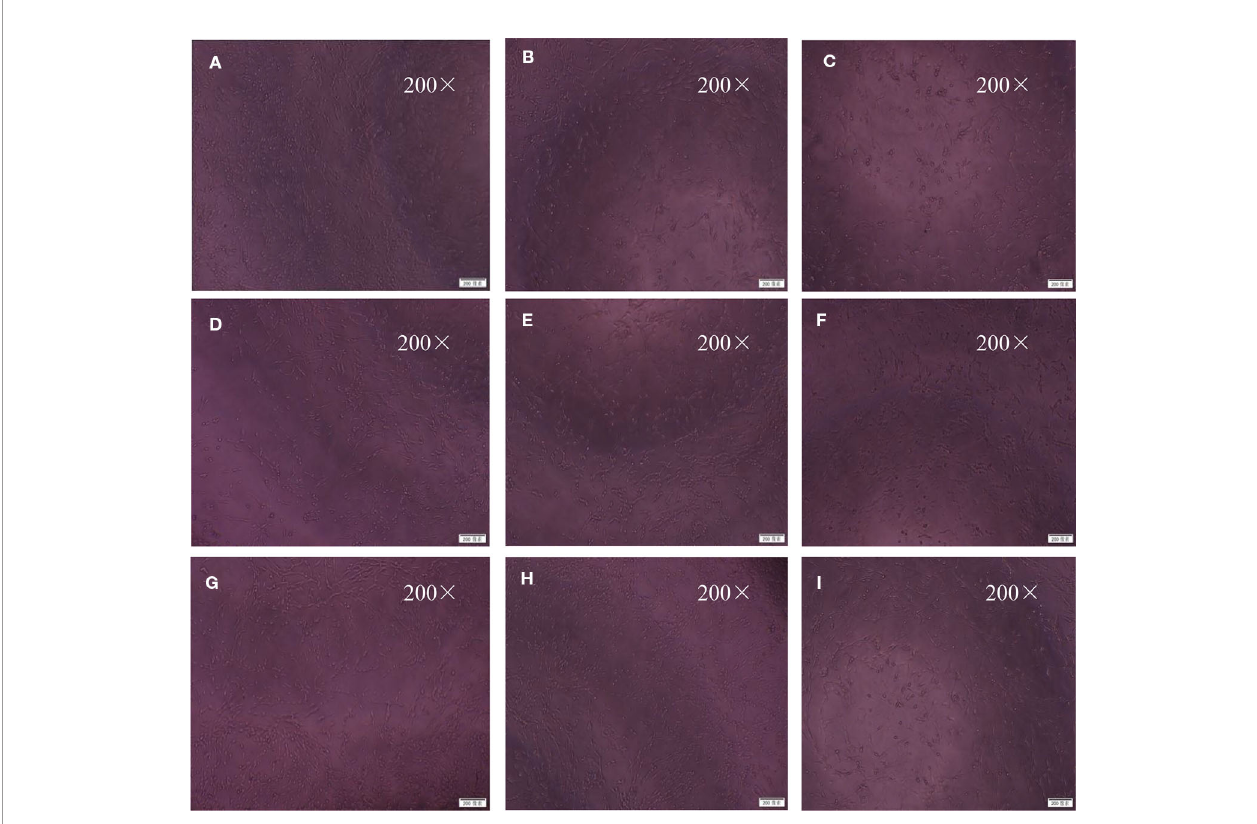
FIGURE 7 | Morphological changes under inverted microscope (200×). The cells were exposed to 30 mmol/L Na 2 S 2 O 4 with low-glucose DMEM for 2 h after treatment with BZP (5 – 40 m mol/L) and C8E4 (30 m mol/L) for 24 h, respectively, and then reoxygenation for 24 h. The groups were as follows: (A) Control group,